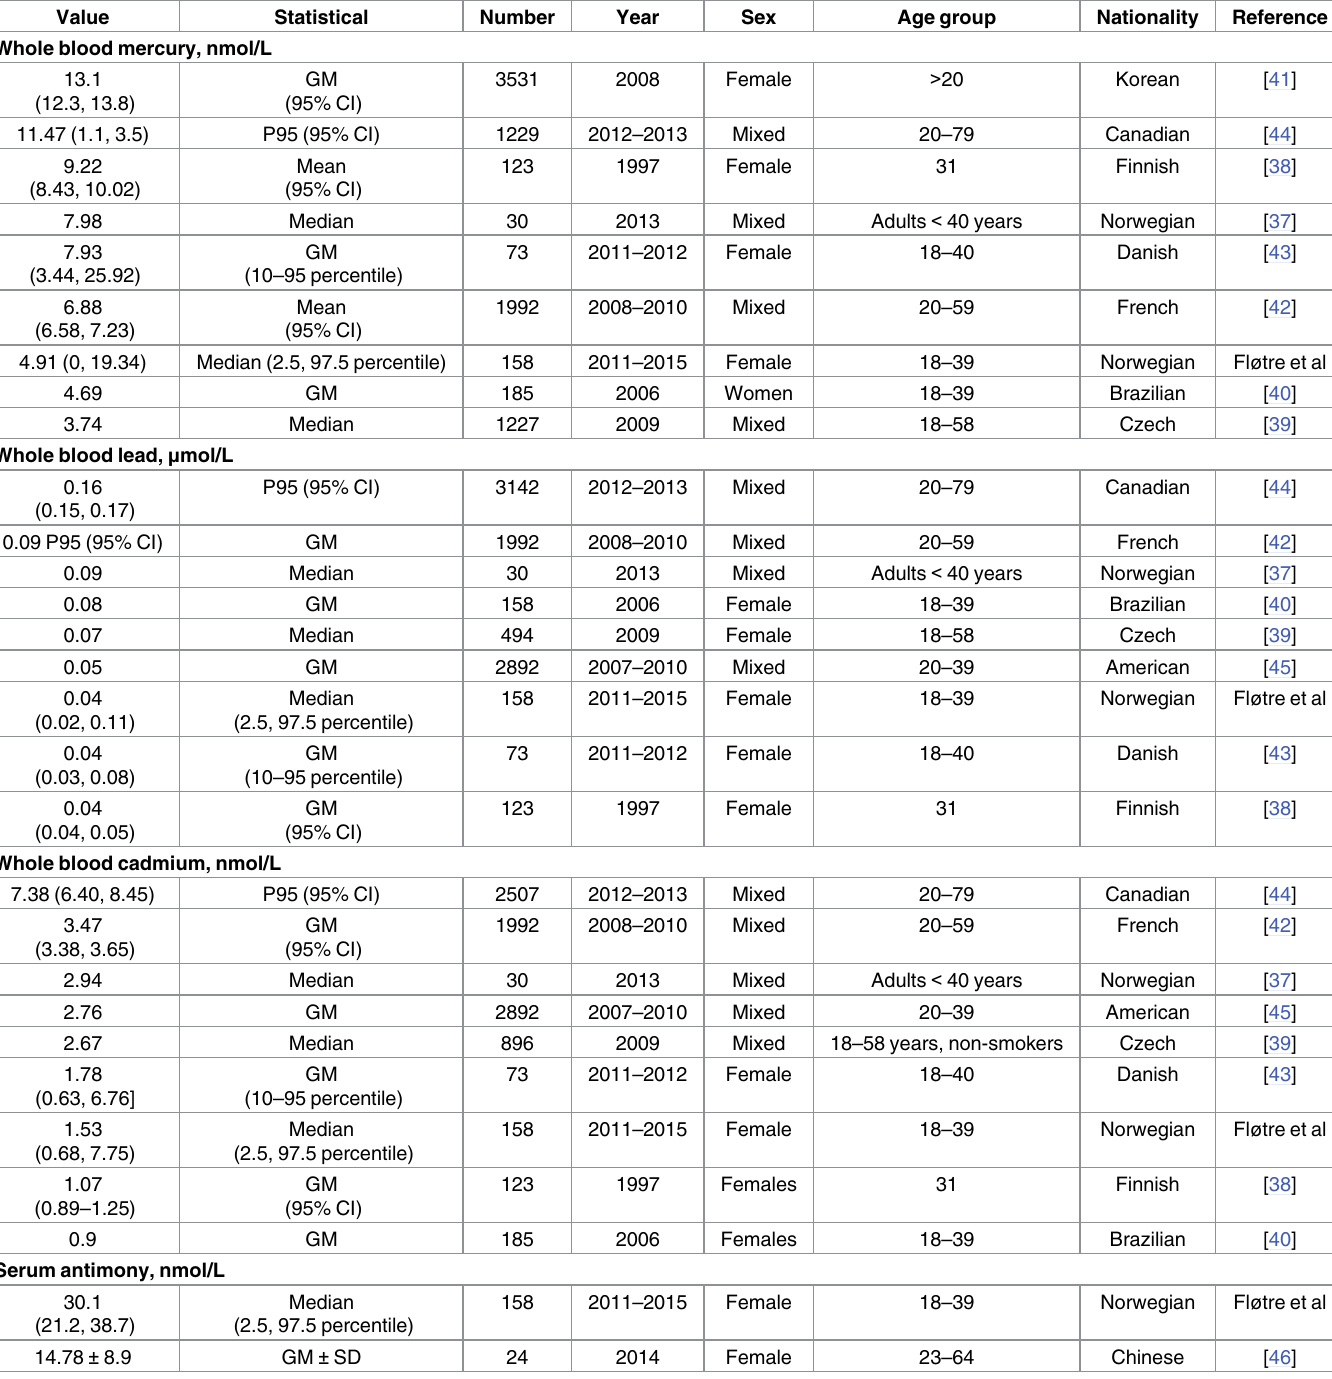
Table 5. Concentrations of whole blood mercury, lead, cadmium and serum antimony in different